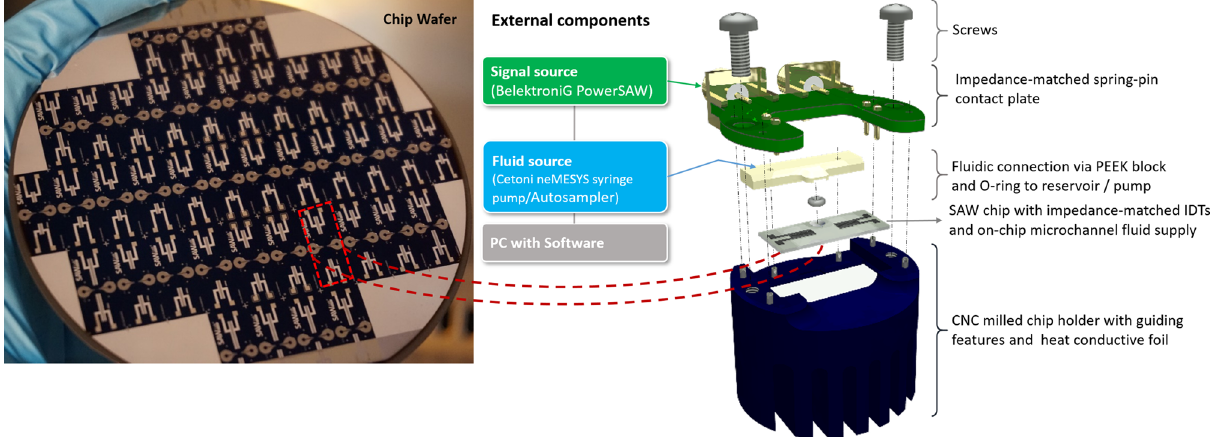
Figure 3. Schematic of the compact SAW aerosol generator and photograph of a wafer with the used SAWN chips (before dicing).